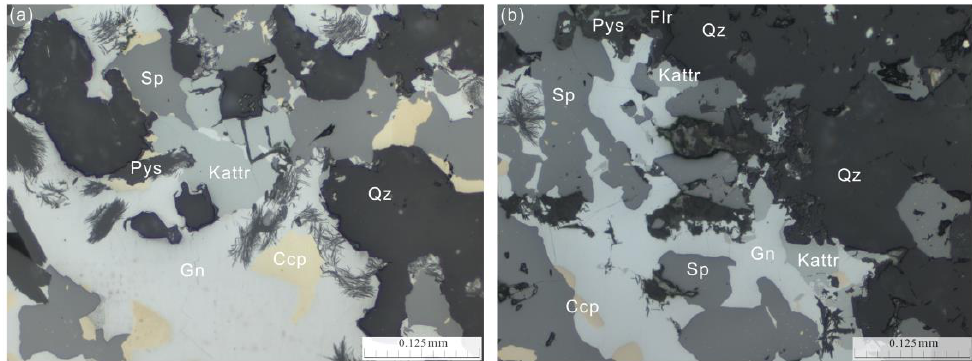
Figure 1. Reflected-light photomicrographs of the polished sections which showing occurrences and mineral associations of kenoargentotetrahedrite-(Fe) (Kattr). (a) The greenish-grey grains of kenoargentotetrahedrite-(Fe) (Kattr) in plane-polarized light. (b) Anhedral grains of kenoargentotetrahedrite-(Fe) (Kattr) associated with galena (Gn), sphalerite (Sp) and chalcopyrite (Ccp) in quartz (Qz) and minor pyrosmalite-(Mn) (Pys) and fluorite (Flr). The compositions of kenoargentotetrahedrite-(Fe) were analyzed with a Shimadzu- 1720 electron probe microanalyzer (EPMA) at accelerating voltage 15 kV and beam size 1 μm. Pure materials of Ag and Cu, ZnS, FeS 2 , CdSe, Sb 2 S 3 , FeAsS and FeS 2 were used as standards for the quantification of Ag(Lα), Cu(Kα), Zn(Kα), Fe(Kα), Cd(Lα), Sb(Lα), As(Lα) and S(Kα) using ZAF correction. The composition data listed in Table 1 were de- rived from analyzing nine positions on the kenoargentotetrahedrite-(Fe) sample. Table 1. Chemical data (wt. %) for kenoargentotetrahedrite-(Fe) (N = 9). Constituent Mean Range Stand. Dev. (σ) apfu . *